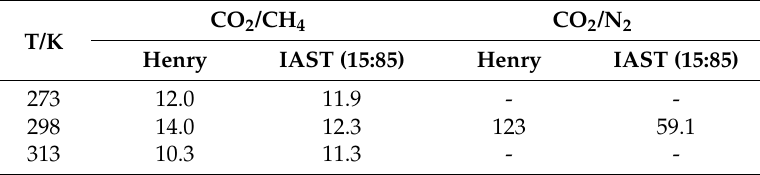
Table 2. Henry and IAST selectivities of BILP-19 for CO 2 over CH 4 and N 2 , respectively. CO 2 /CH 4 CO 2 /N 2 T/K Henry IAST (15:85) Henry IAST (15:85) 273 12.0 11.9 - - 298